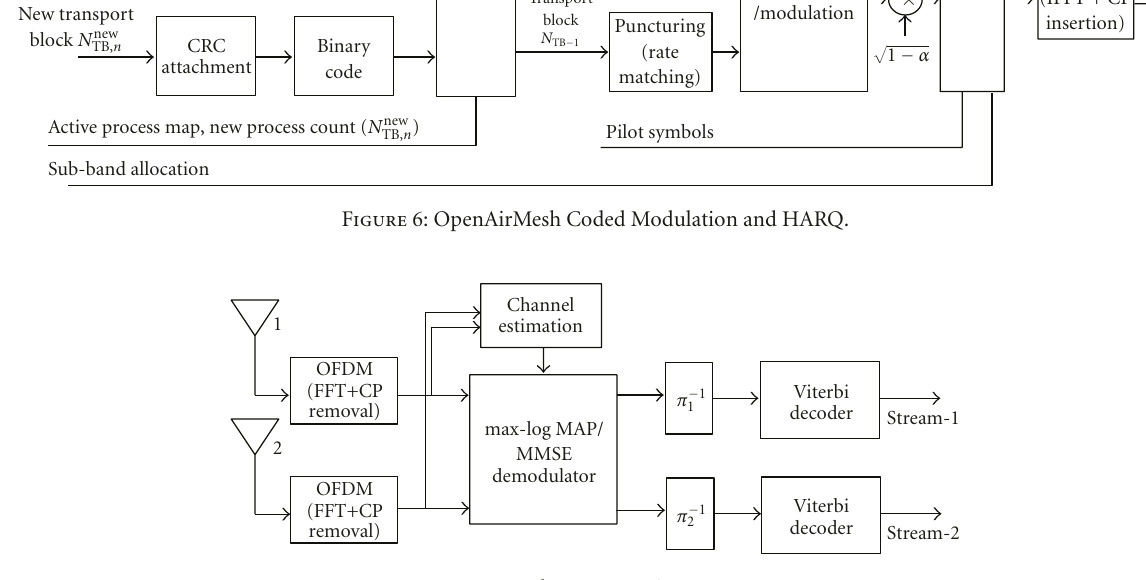
Figure 7: Dual-stream receiver